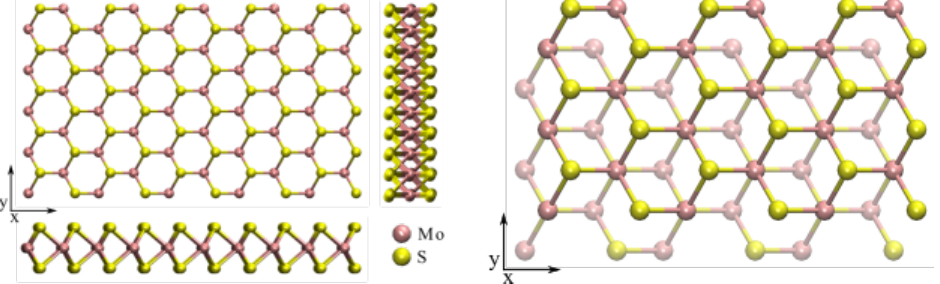
Figure 6. Schematic structure of MoS 2 single and